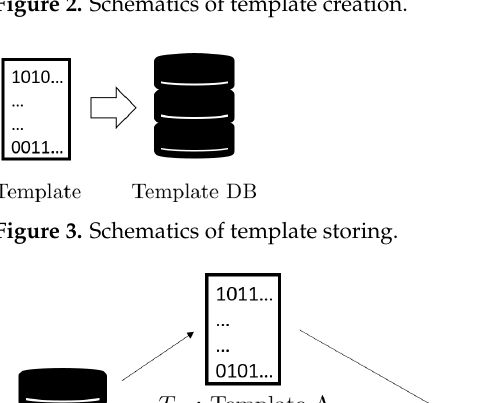
Figure 2. Schematics of template creation.